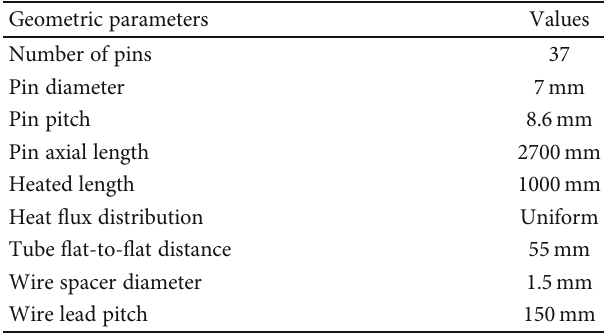
Table 1: Geometric parameters of test